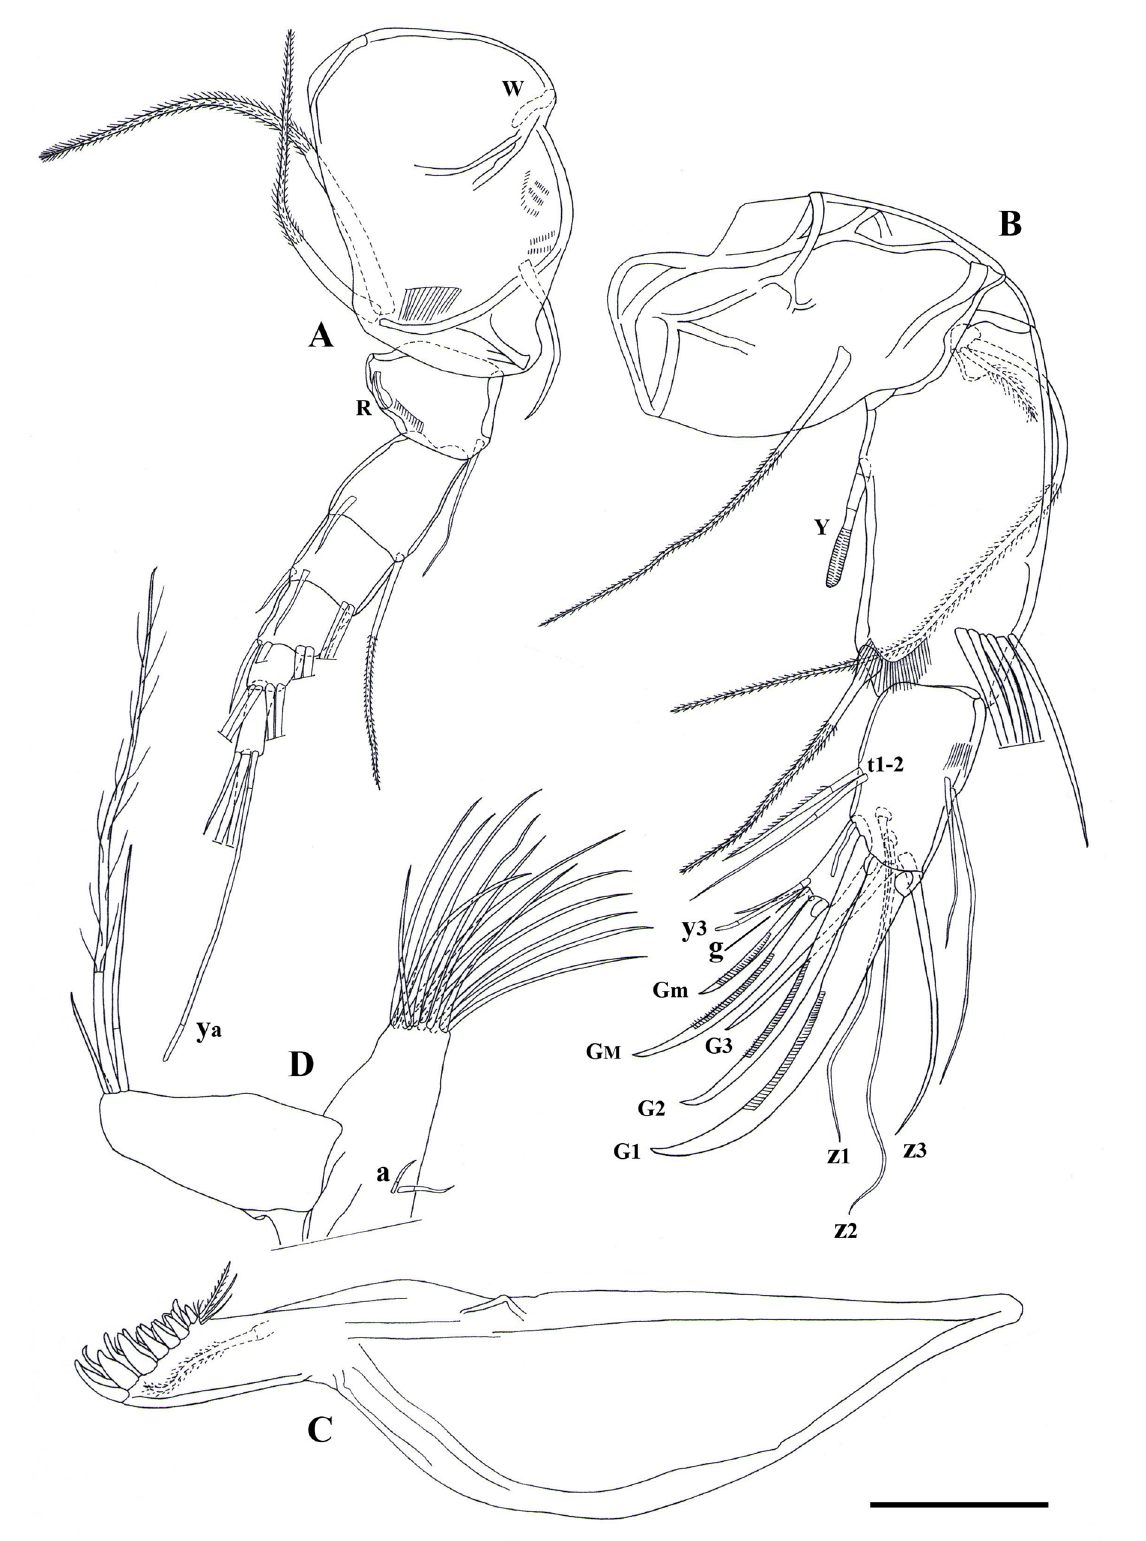
Fig. 6. Siamopsis suttajiti gen. et sp. nov., ♀ (MSU-ZOC.195). A . A1. B . A2. C . Md coxa. D . T1. Scale bar: 50